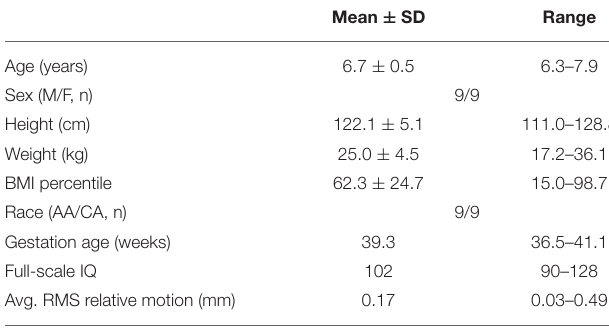
TABLE 1 | Basic characteristics of study population ( n =